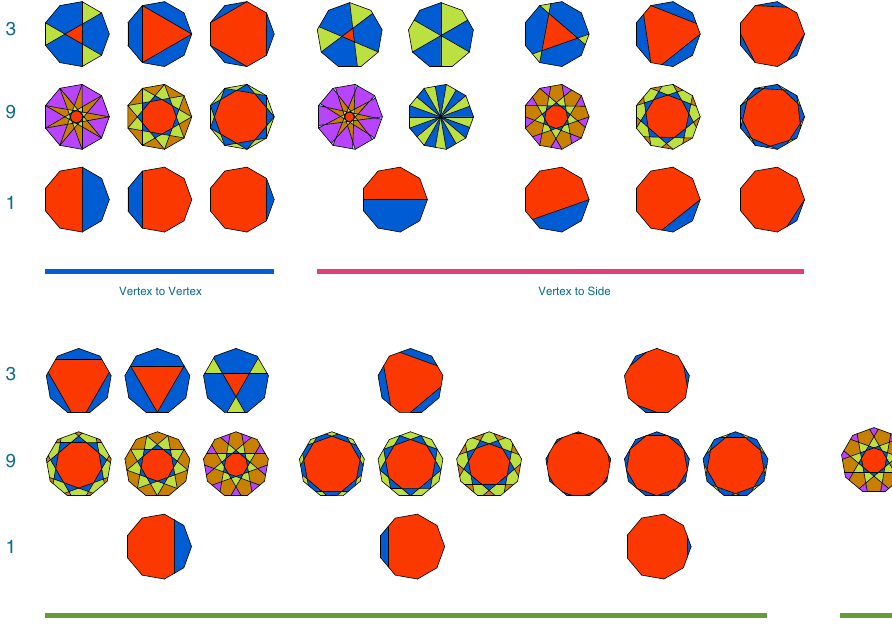
Figure n9A. Nonagons ( m =